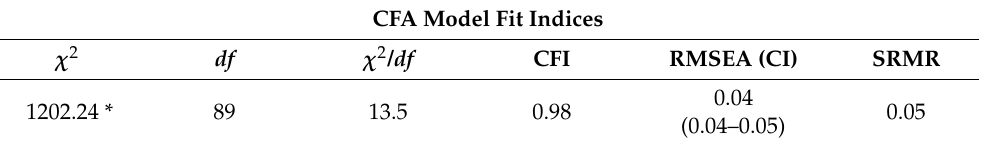
Table 8. Confirmatory factor analysis: Model fit